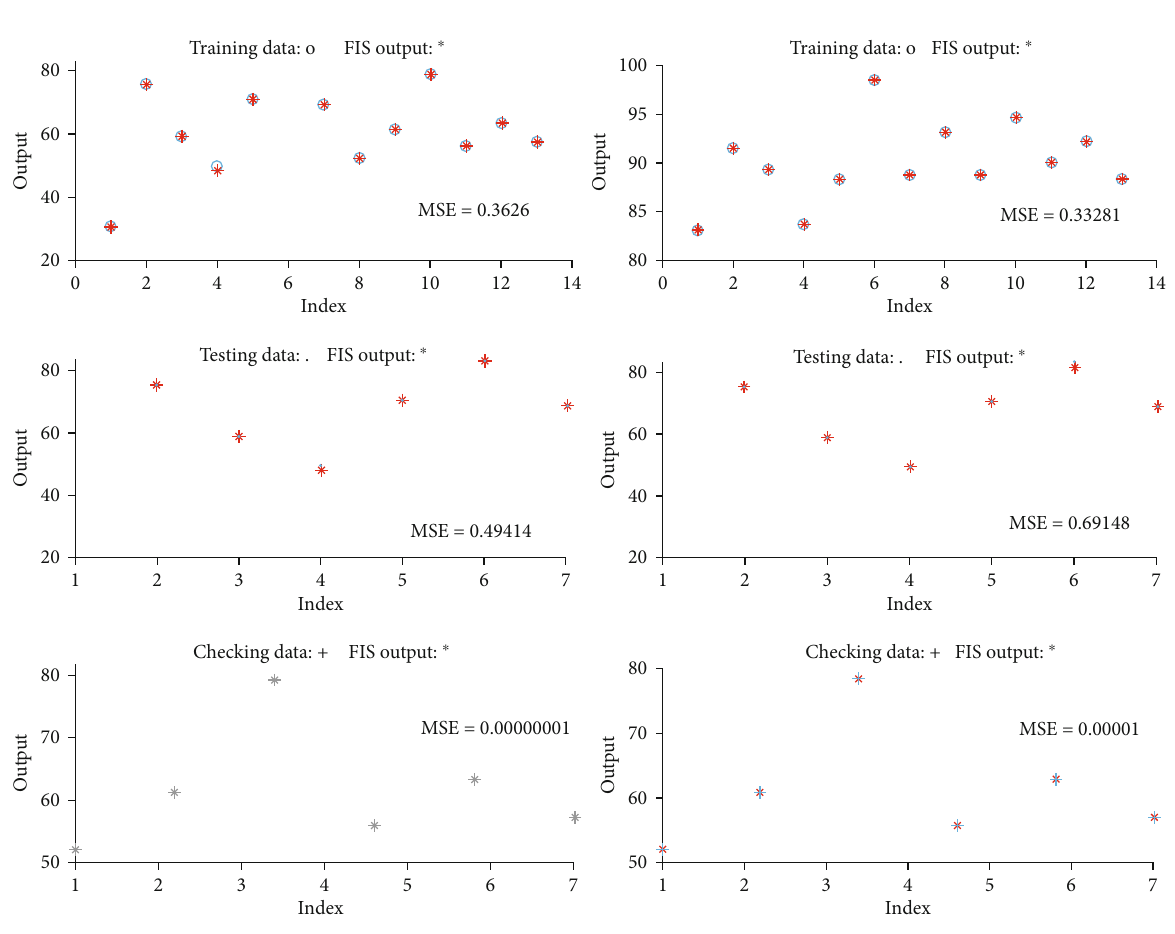
Figure 6: Modeling results using ANFIS for (a) CD removal e ffi ciency and (b) TOC removal e ffi